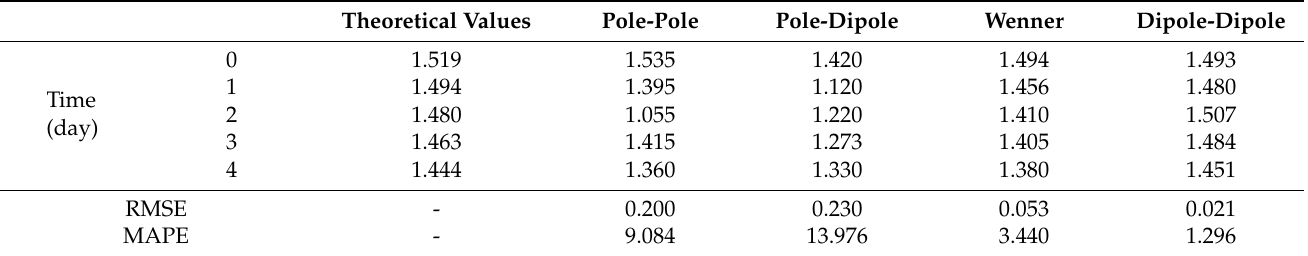
Table 4. The FOS obtained by the proposed framework in the 3% Gaussian noise scenario of multi- ple arrays.